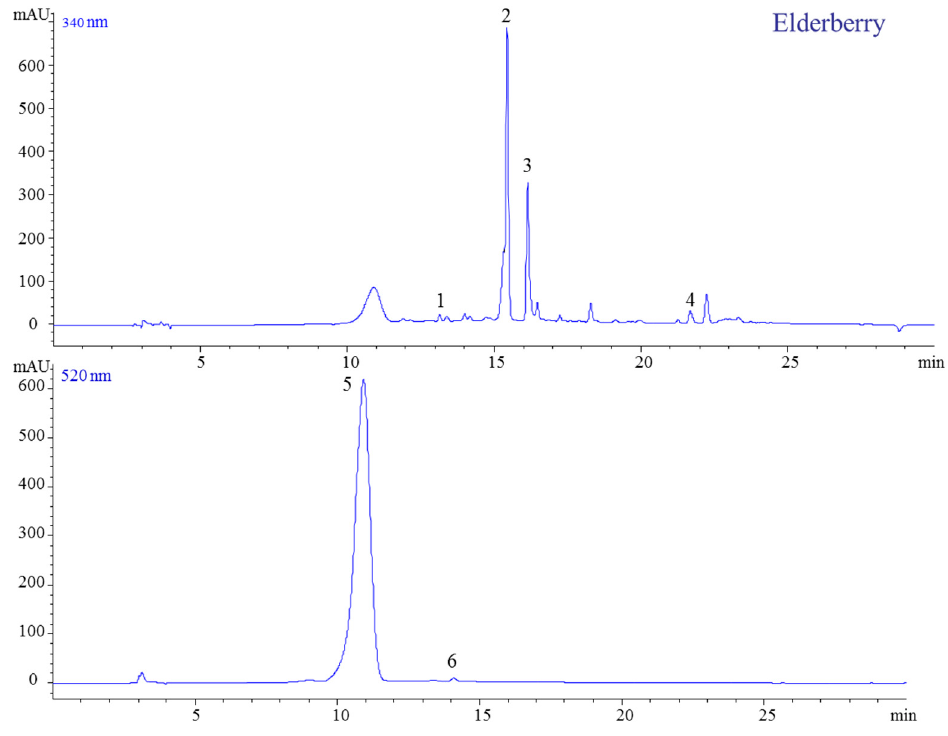
Figure 7. HPLC-DAD chromatogram of berry extracts from elderberry jams (340 and 520 nm).